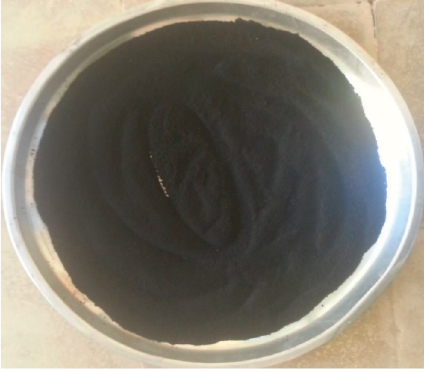
Figure 1: Images of coffee husk ash Table 1: Major chemical compounds of CHA.